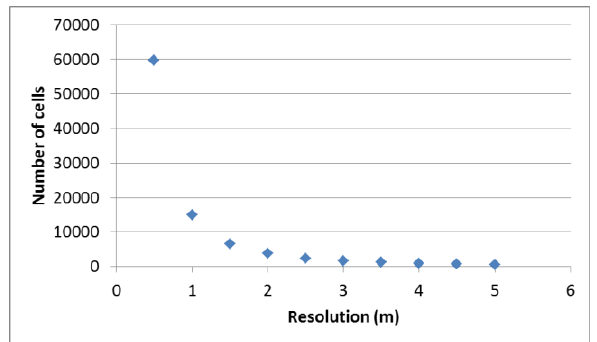
Figure 9. Relation between the number of cells of the DEM and cell resolution.